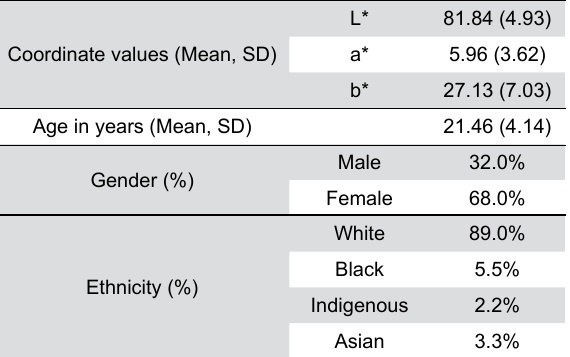
Coordinate values (Mean, SD)